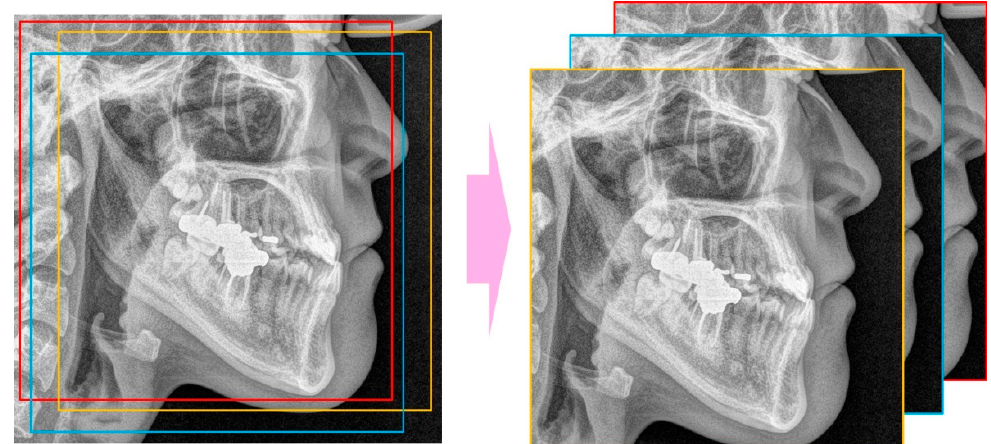
Figure 3. Random cropping to get 224 × 224 images from 256 × 256 image.